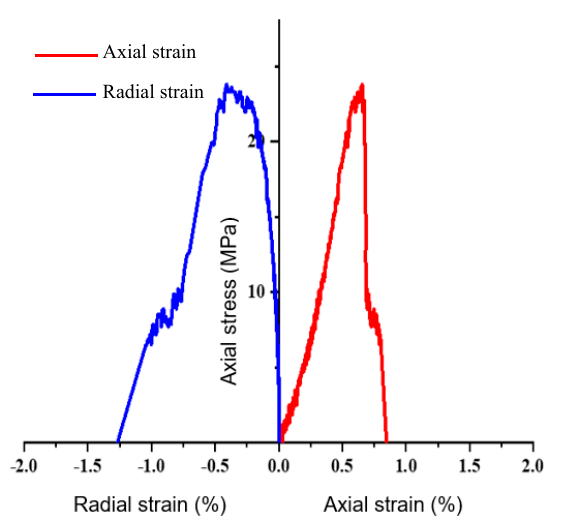
Figure 2. Triaxial compressive stress − strain curve of medium porosity and medium permeability sandstone.